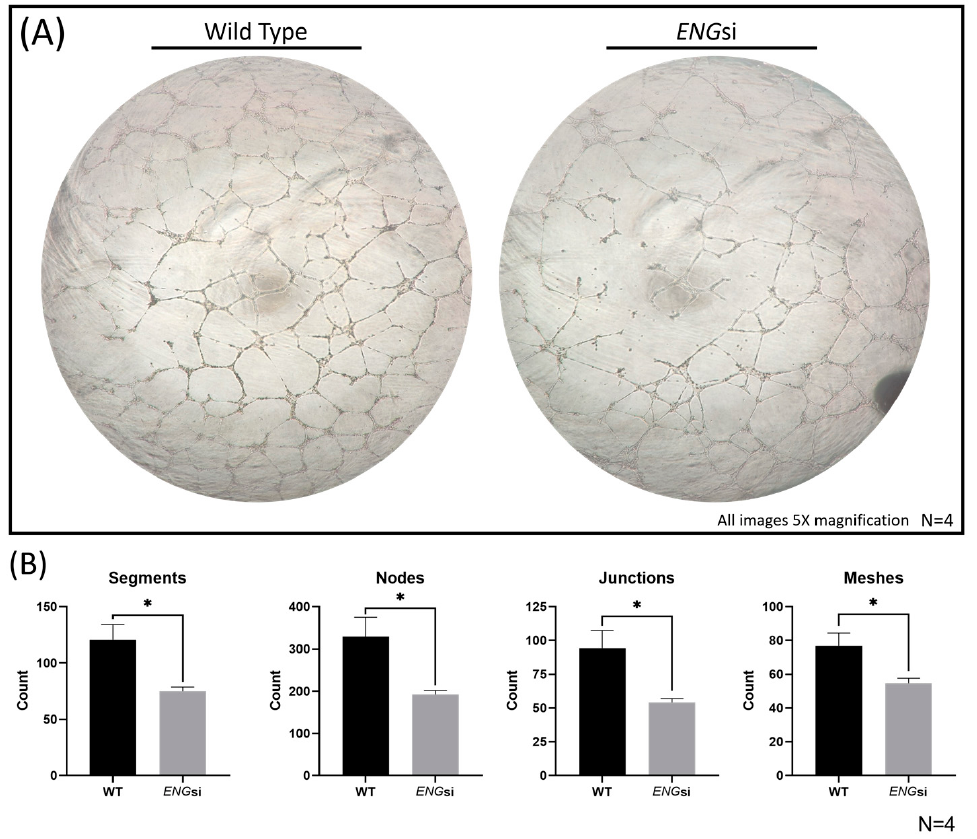
Figure 8. In vitro tube formation assay of wild-type (WT) HUVECs compared with that of ENG - knockdown ( ENG si) HUVECs. ( A ) Images taken at 16 hours of WT and ENG si HUVEC tube formations (5 × magnificaiton). ( B ) Significantly lower counts of segments, nodes, junctions and meshes were detected for HUVECs with ENG -knockdown ( ENG si) compared with those in WT HUVECs (N = 4). * p < 0.05.